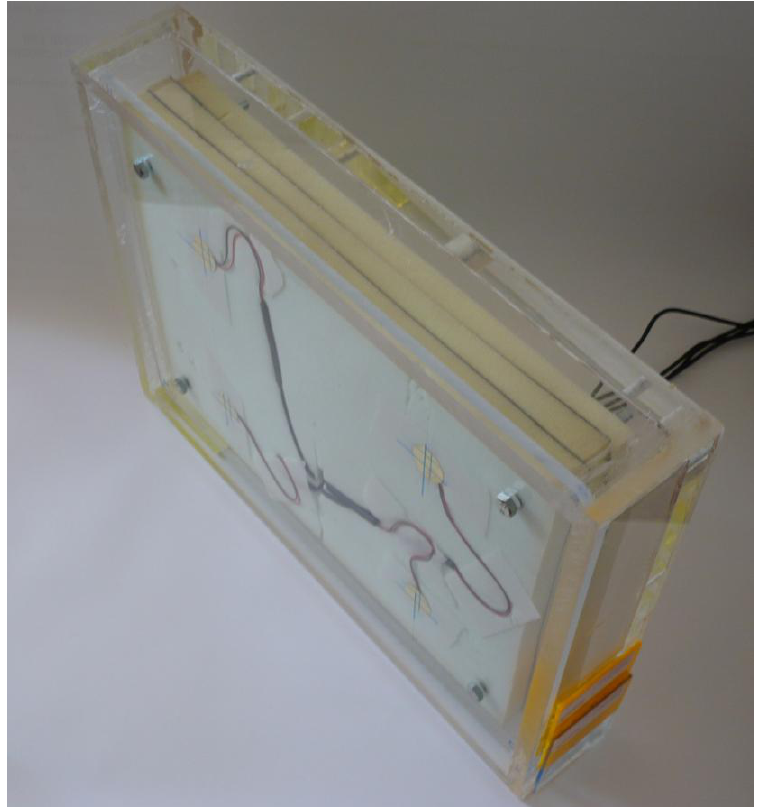
Figure 8. Wired prototype, after slight modifications to fit the pilot testing